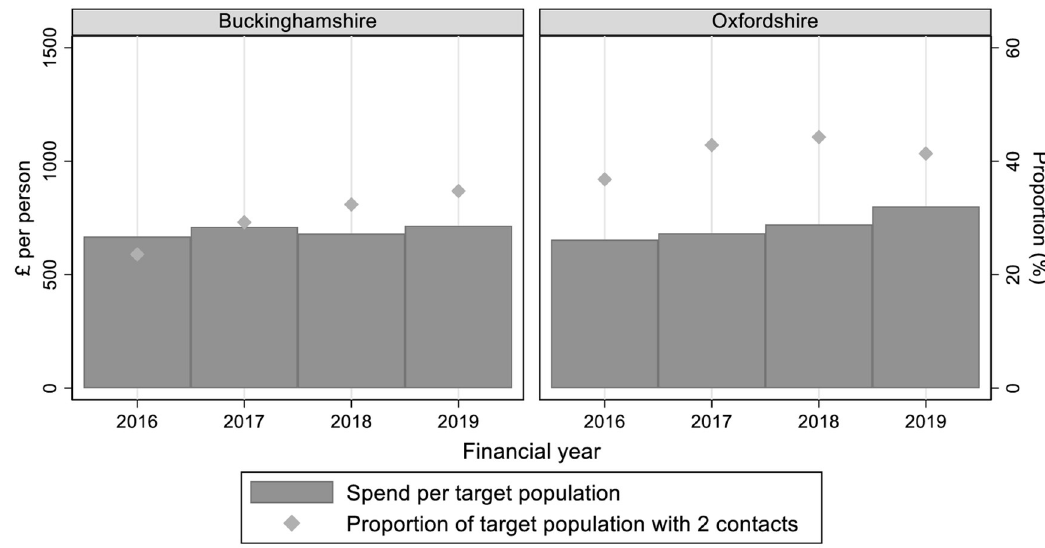
Fig 2. CAMHS budget and performance against attendance